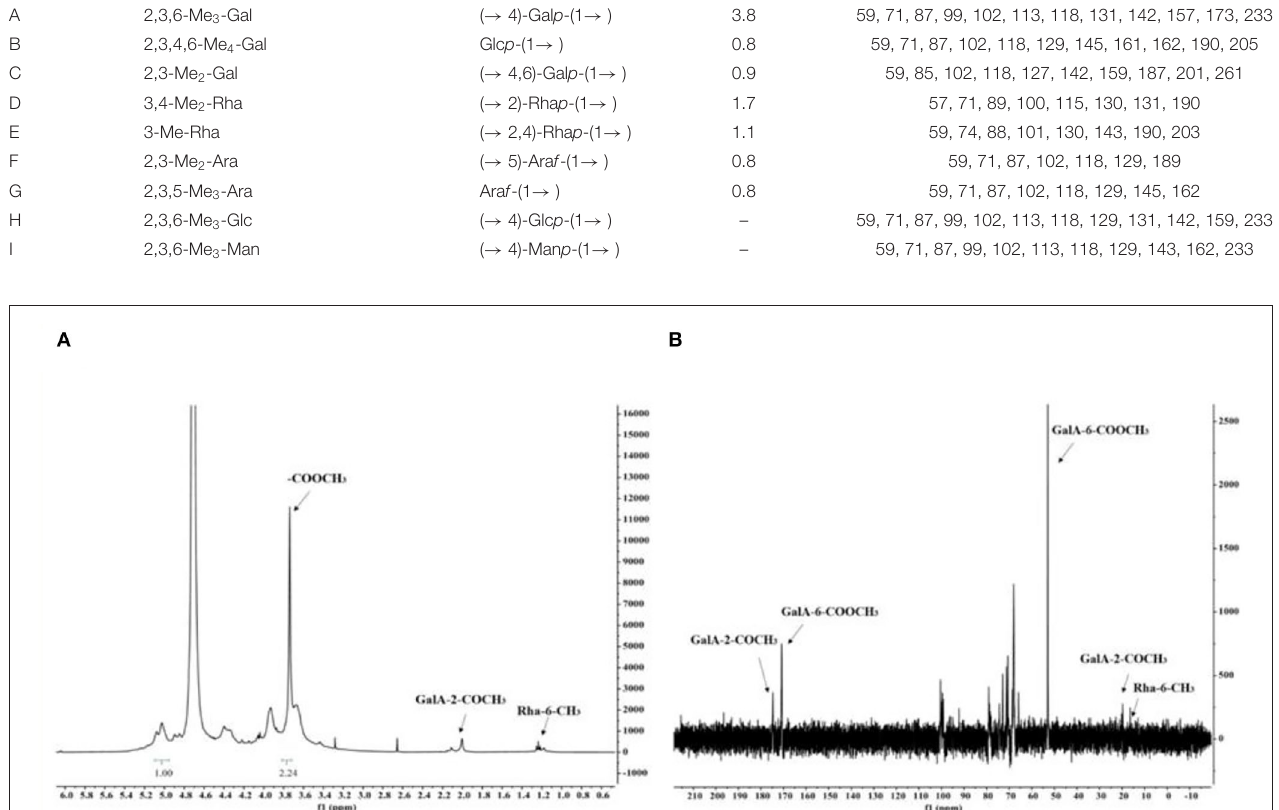
FIGURE 3 | The 1 H NMR spectra (A) and 13 C NMR spectra (B) of RCHP-S.